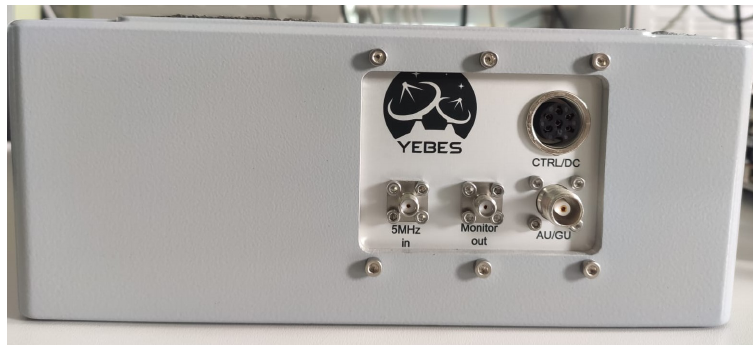
Figure 6. External view of phaseCal